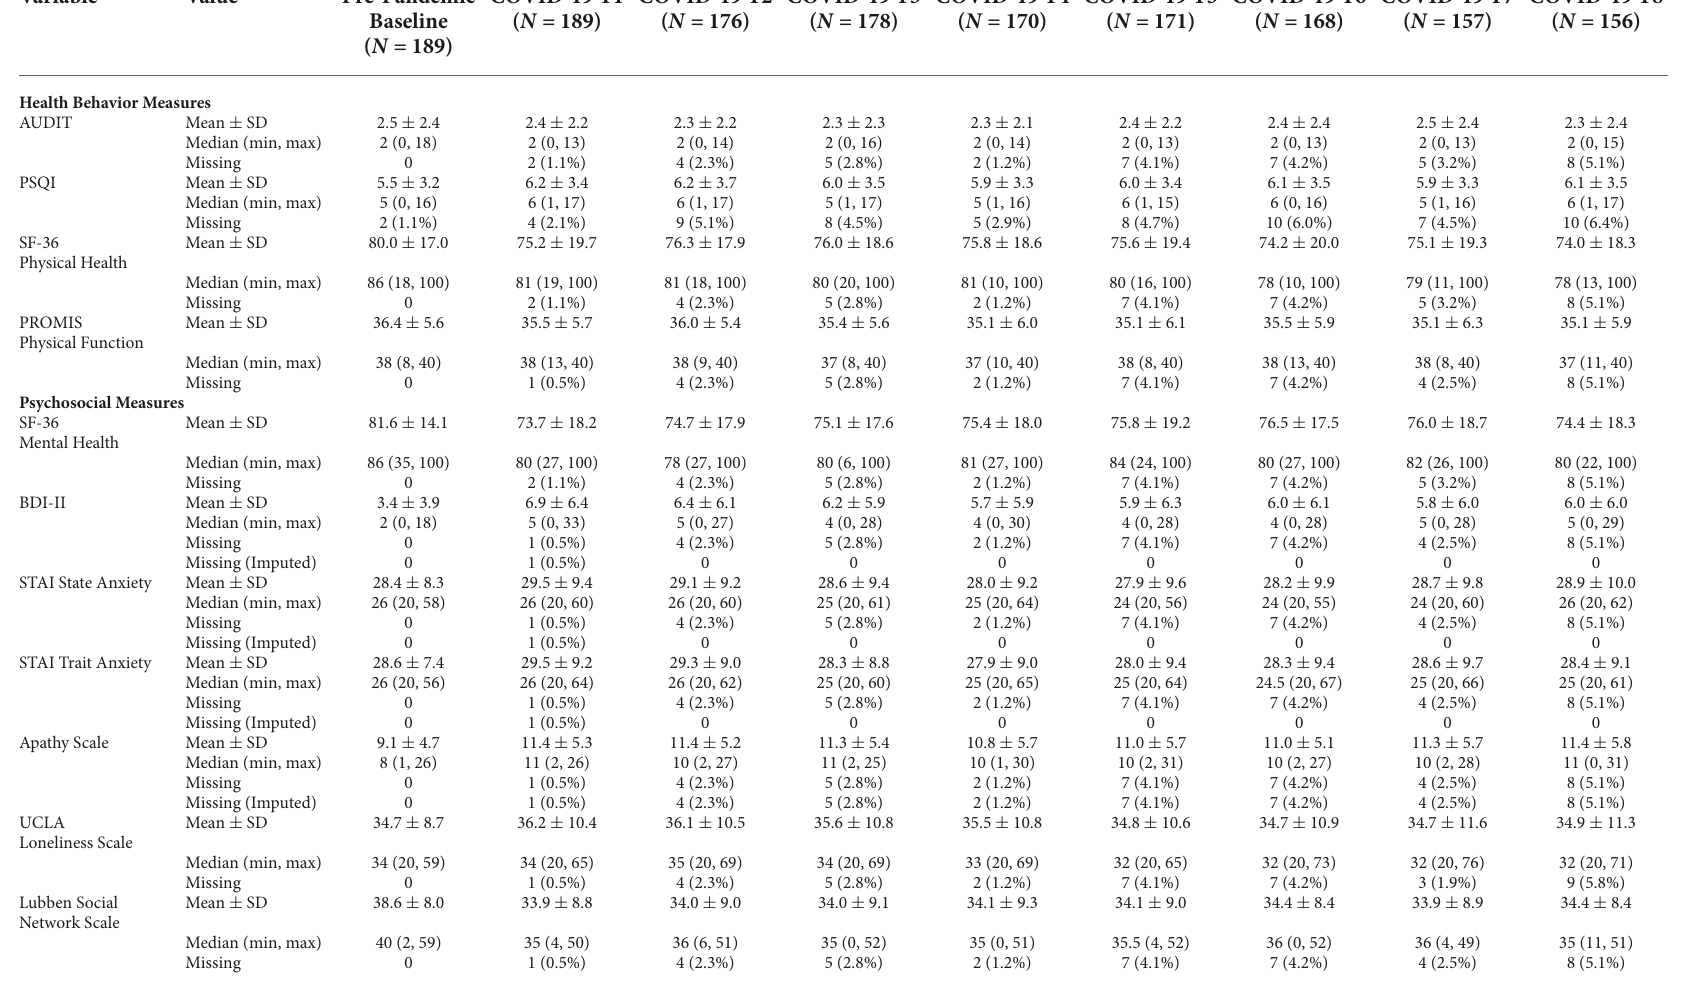
TABLE 2 Assessments by